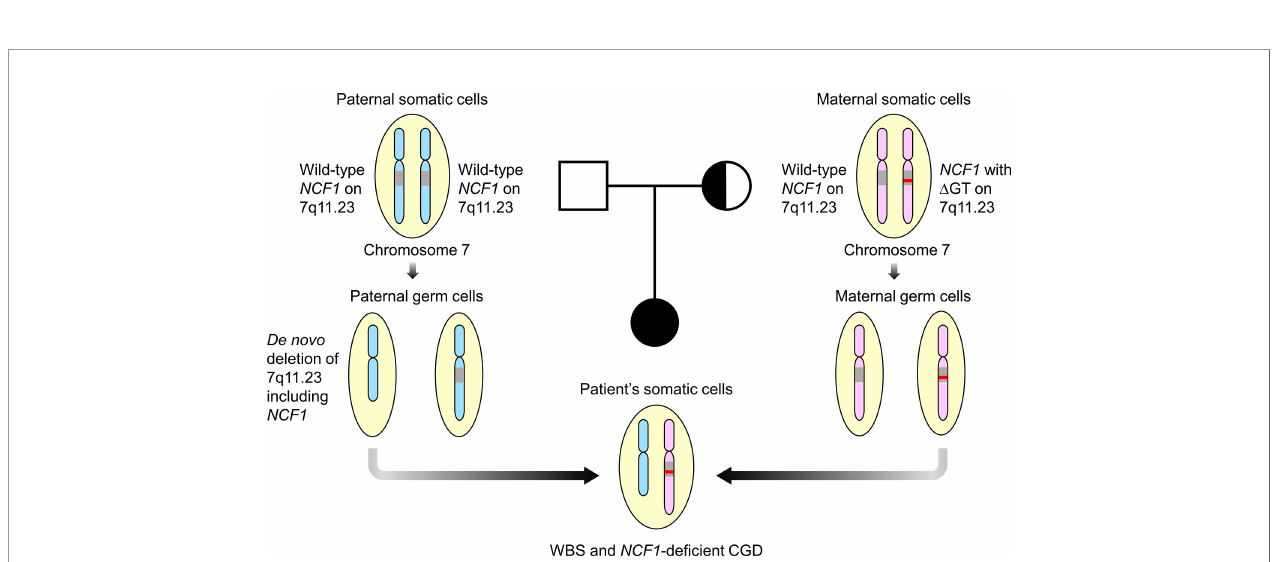
FIGURE 4 | Familial segregation analysis. The patient was postulated to inherit a paternal allele with de novo 7q11.23 deletion involving NCF1 and a maternal allele with D GT-containing NCF1 , resulting in Williams-Beuren syndrome (WBS) and NCF1 -de fi cient chronic granulomatous disease (CGD). Both parents were well with no features of WBS and CGD. Square symbol indicates male, half- fi lled circle indicates female carrier of NCF1 with D GT and fi lled circle indicates female affected by WBS and CGD. The diagram was not drawn to scale. D GT, GT-deletion; WBS, Williams-Beuren syndrome; CGD, chronic granulomatous disease.